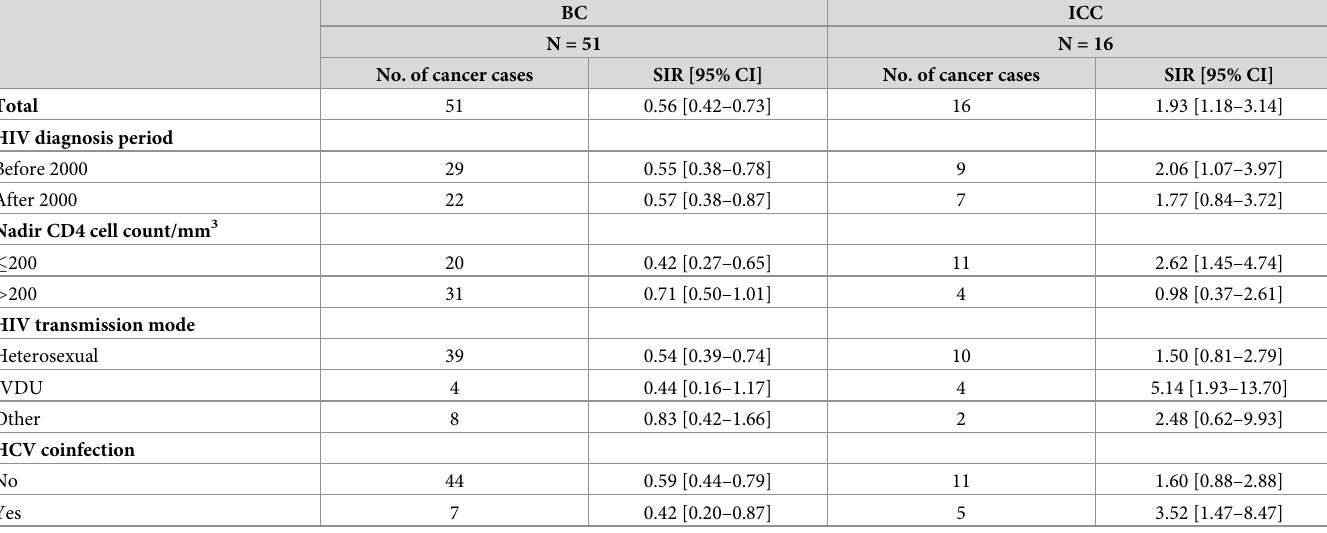
Table 3. Standardized incidence ratios of breast cancer and invasive cervical cancer in women in the Dat’AIDS cohort between January 1, 2010 and December 31, 2015 (N = 13,543).